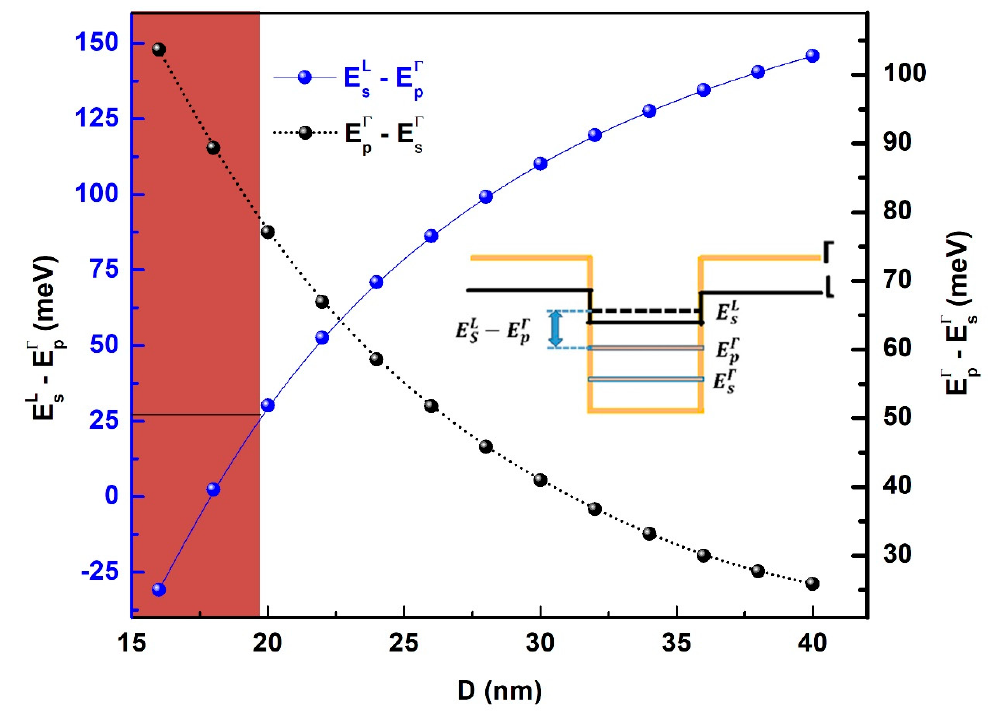
Figure 2. Intersubband transition energy ( E Γ p − E Γ s ) and energy difference between p -like electron energy level in Г -valley and s -like electron energy levels in L valley ( E L s − E Γ p ) as a function of the QD diameter.